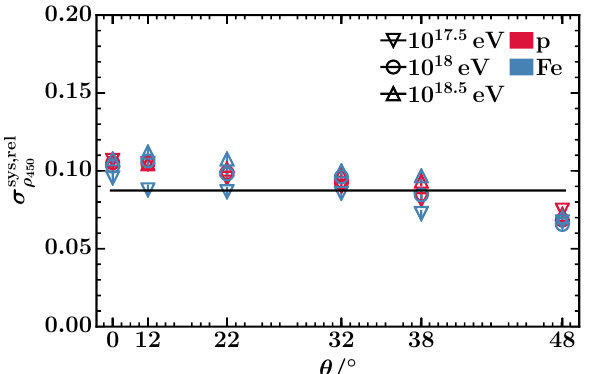
Figure 4: Relative systematic uncertainty σ sys , MLDF / ρ to the use of a parametrized MLDF slope β ( θ ) as a func- tion of θ obtained with the QGSJ et II-04 hadronic interaction model for proton and iron primaries at di ff erent energies. Markers are the mean values, and error bars their standard error. The average uncertainty is 8 . 8%